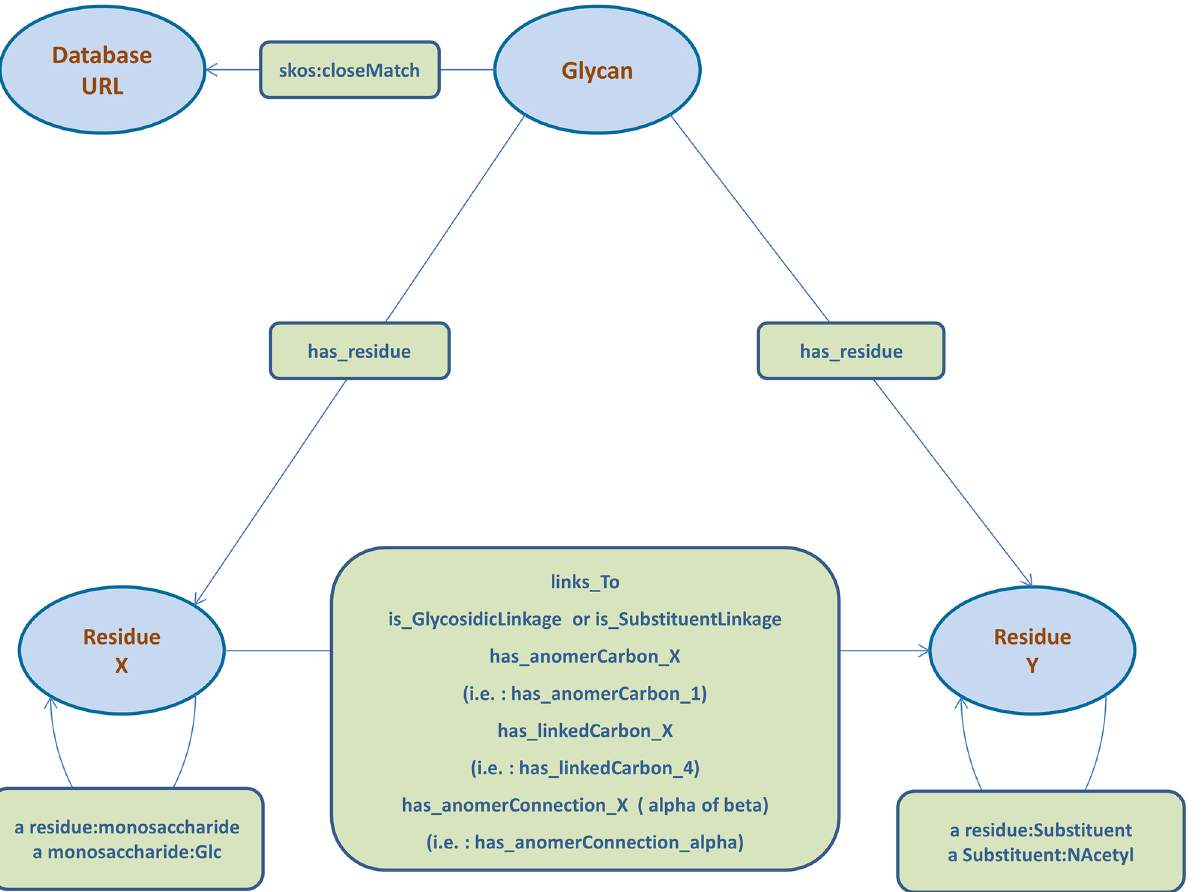
Fig 2. Ontology overview. Overview of the ontology developed for translating glycan structures into RDF/semantic triples. The figure shows all the predicates and the entities used for defining a glycan structures into the RDF triple